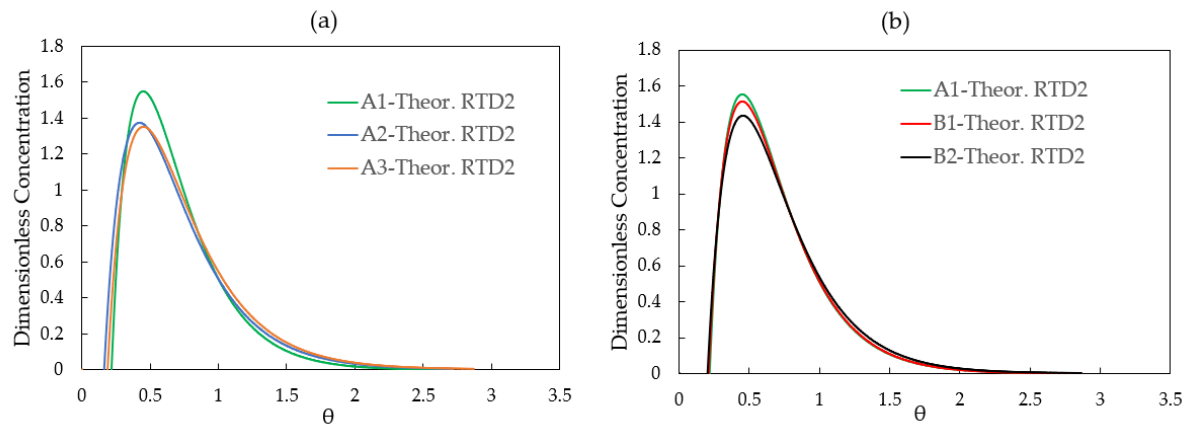
Figure 9. Calculated RTD curves using tanks-in-series model ( a ) Group 1—variation of distance between weir and inlet ( b ) Group 2—variation of depth of weir.